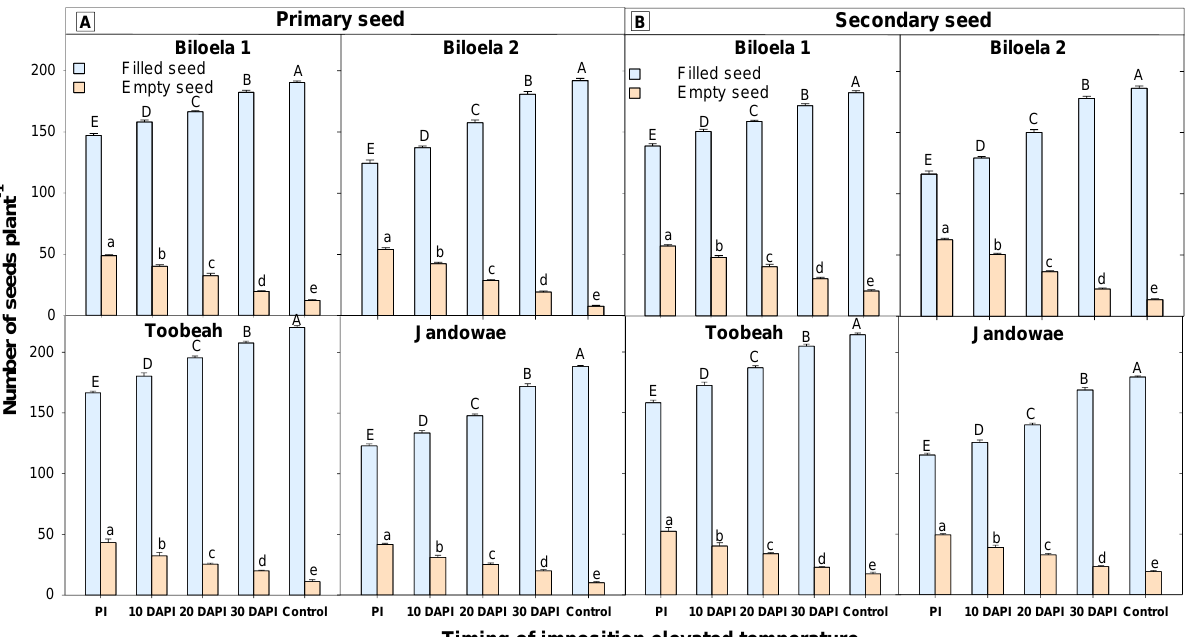
Figure 3. Effect of elevated temperature applied at panicle initiation (PI), 10 days after panicle initiation 10 DAPI, 20 DAPI or 30 DAPI, on the production of filled and empty ( A ) primary seeds, ( B ) secondary seeds plant − 1 of four Avena sterilis ssp. ludoviciana biotypes. Error bars represent standard errors of the mean of 12 replicates and represent pooled data from two experimental runs. Letters within a biotype indicate significant differences among the treatments (Bonferroni test). Upper- and lower-case letters are used for filled and empty seeds, respectively.